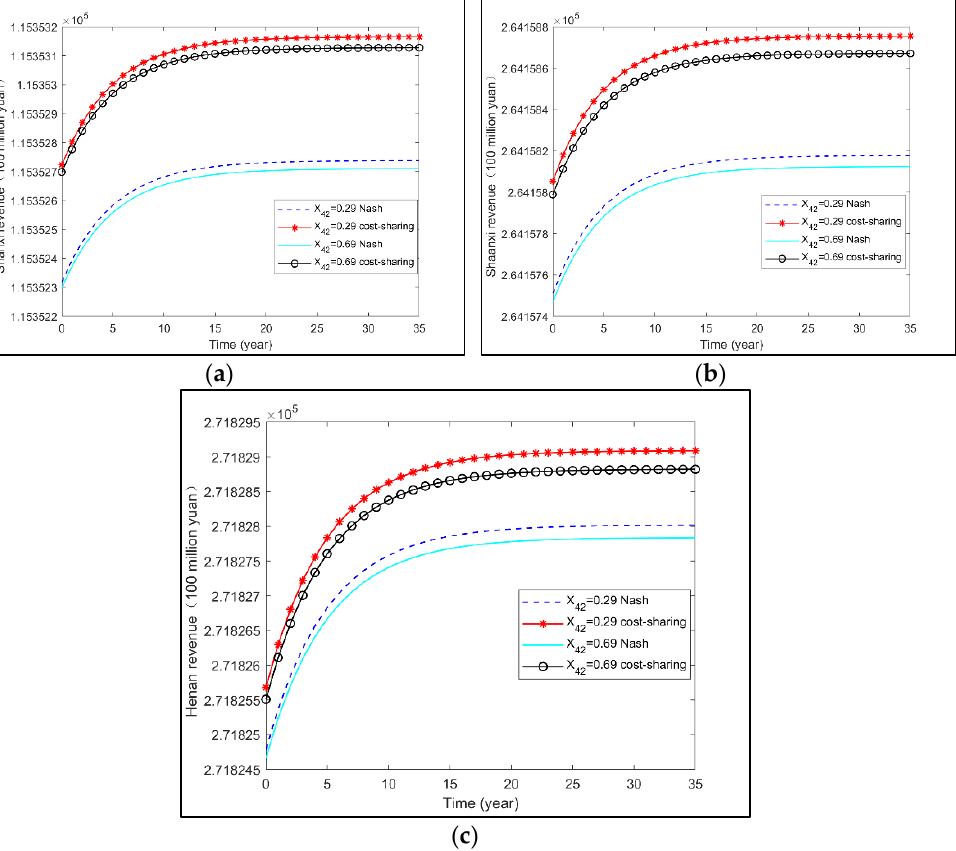
Figure 15. The effects of Shaanxi province’s X 42 on each government’s revenues: ( a ) the Shanxi province government’s revenues, ( b ) the Shaanxi province government’s revenues, and ( c ) the Henan province government’s revenues.